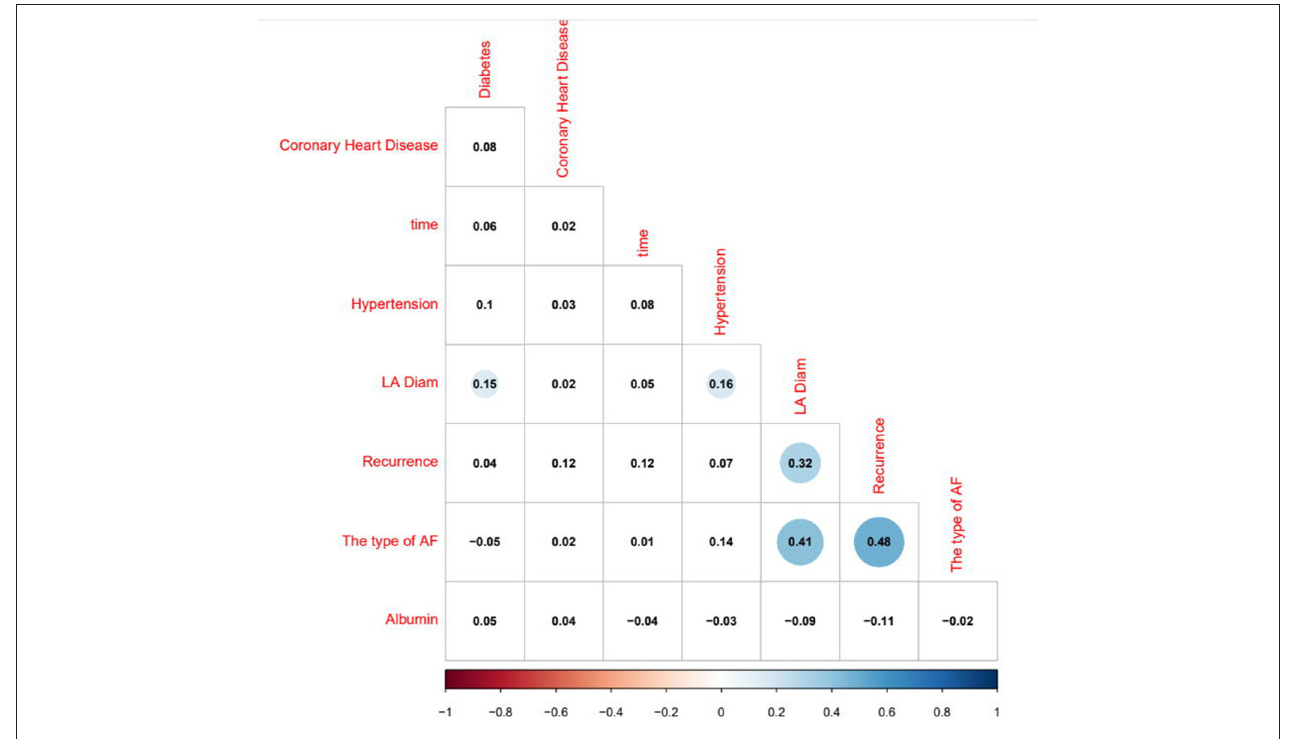
FIGURE 5 | Heatmap of correlation coefficients after logistic regression modeling.